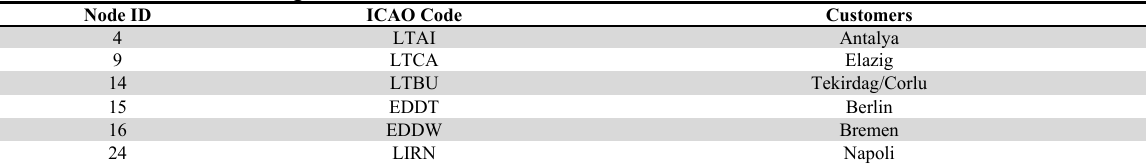
Customers with fast demand